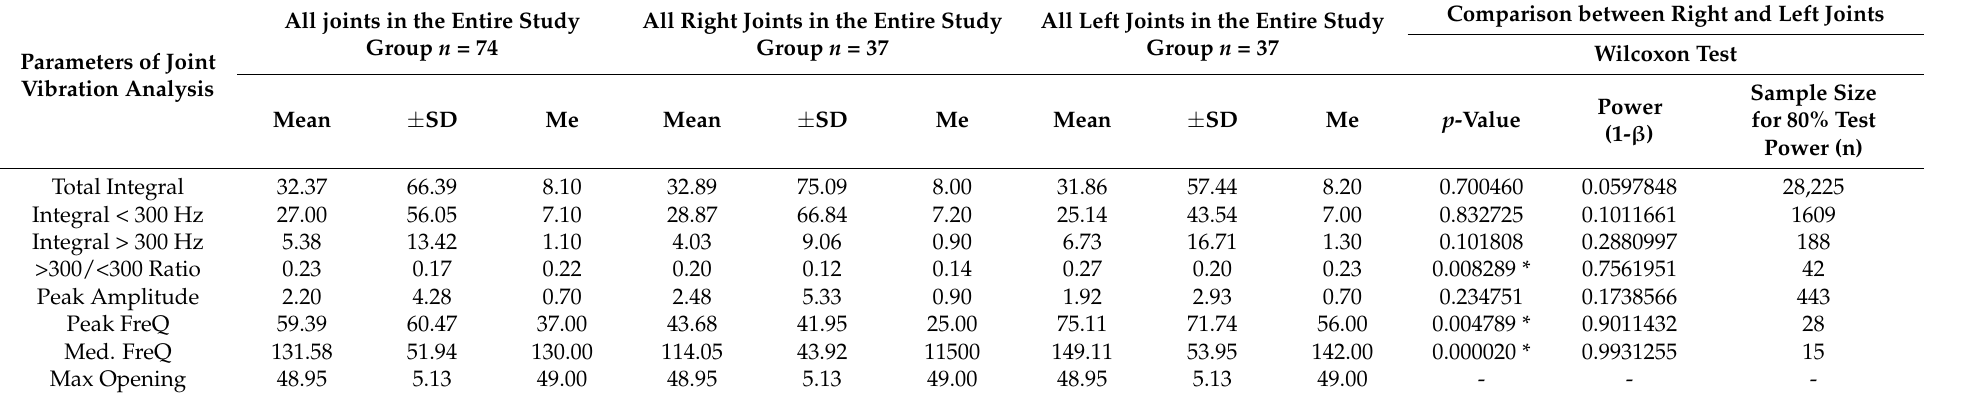
Table 4. Parameters of temporomandibular joint vibration analysis in the female group ( n = 37). The mean values, standard deviation ( ± SD), median (Me) and p -value are given.